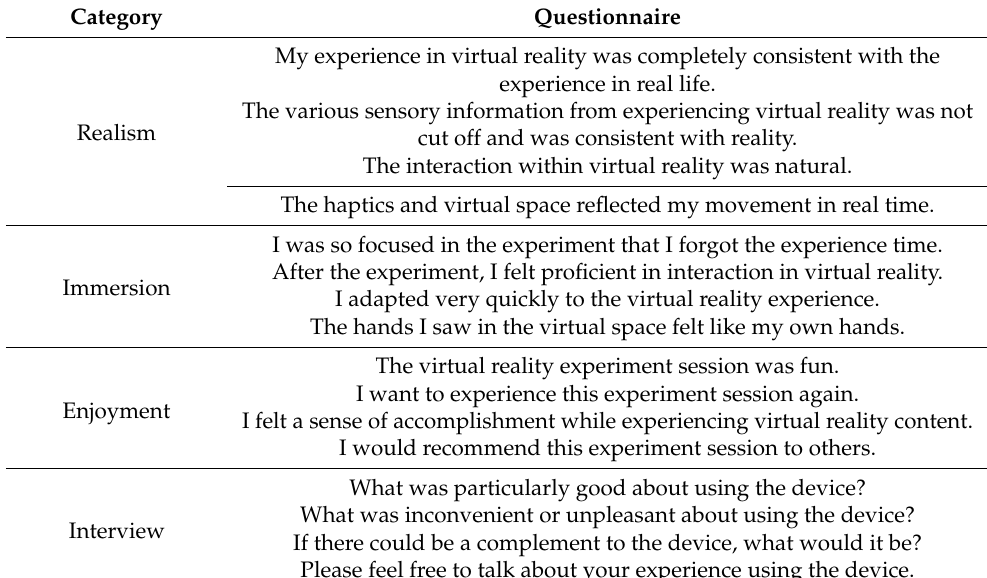
Table 2. Questionnaire and interview